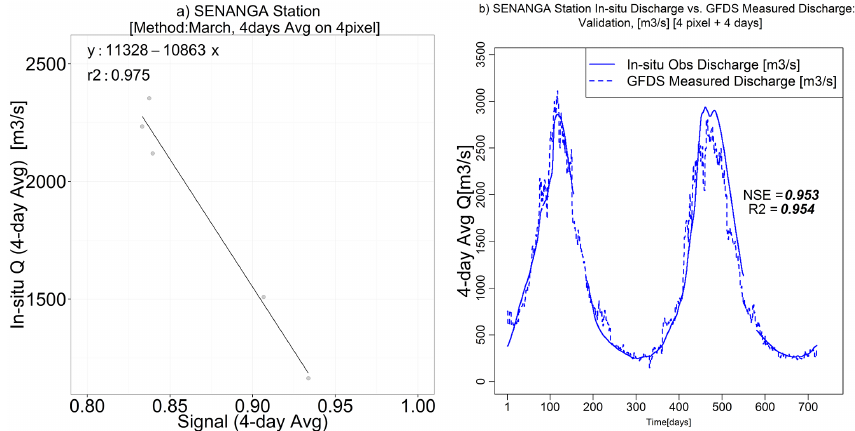
Figure 3. (a) Scatterplot for the Senanga station (long 23.25degree, lat − 16.116degree) in the Zambezi River (Africa). Monthly mean for March from 1998 up to 2002. (b) Validation hydrograph for 2003–2004 and skill scores for Senanga. The (monthly) rating equations were used to calibrate the signal into discharge units. Different rating equations were used for different